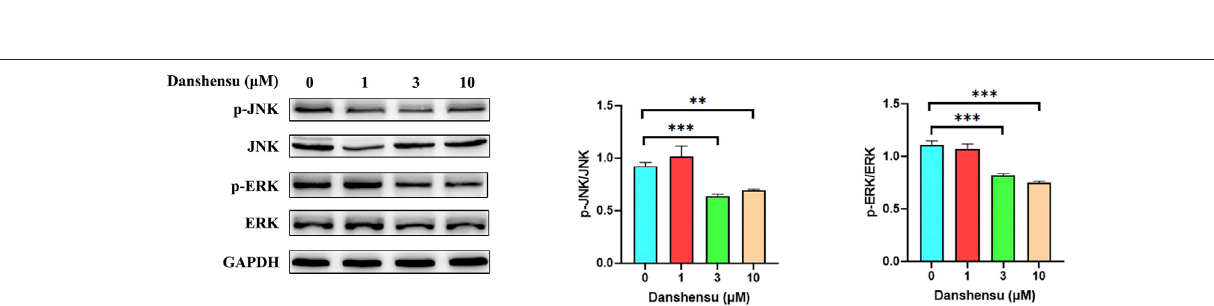
Frontiers in Pharmacology |